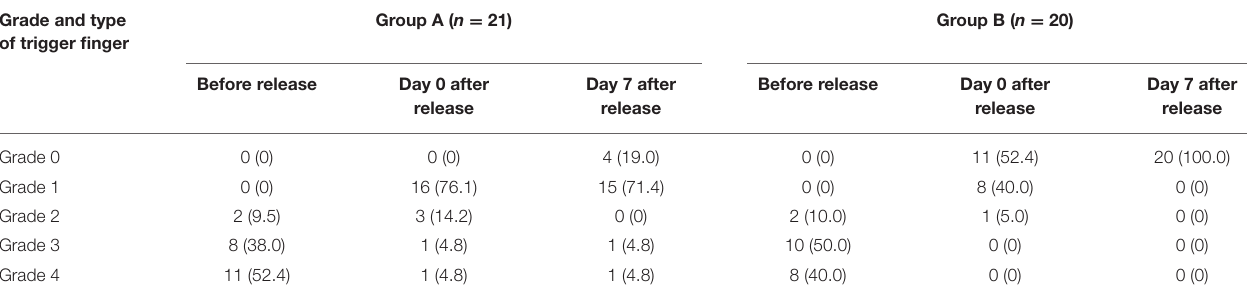
TABLE 2 | Type of Trigger Finger before Release, Day 0 and Day 7 after Release ( n = 41).